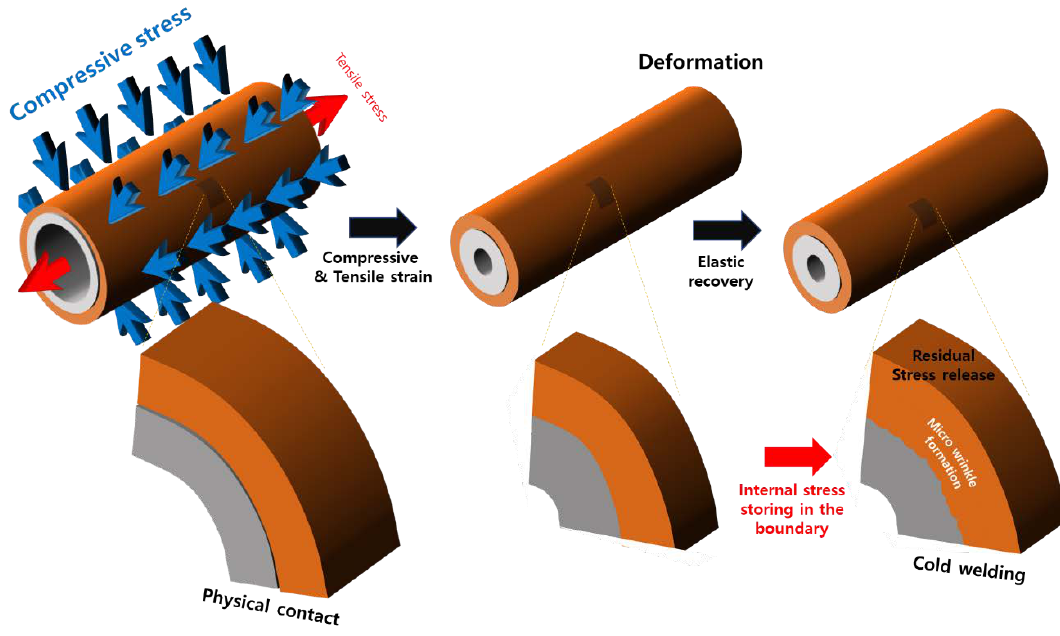
Figure 2. Mechanism of swaging.